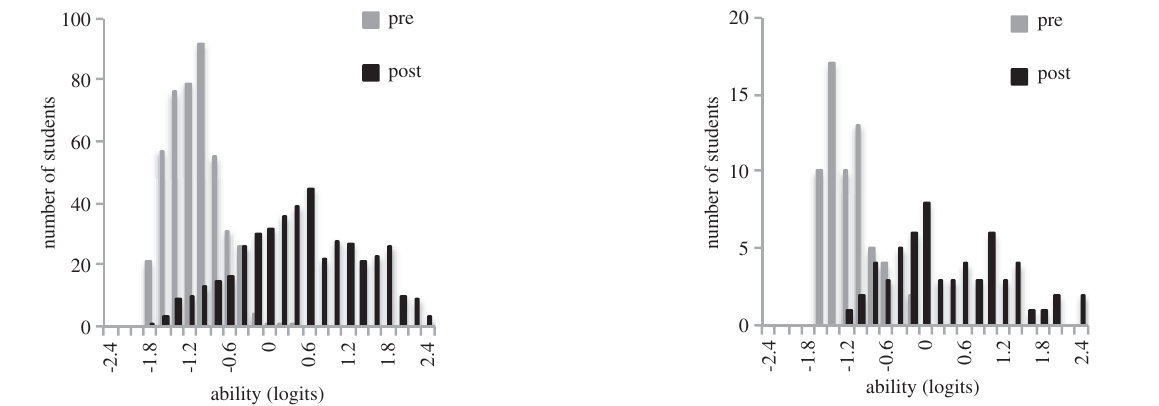
FIG. 21. The pre- and postability histogram for class 7.